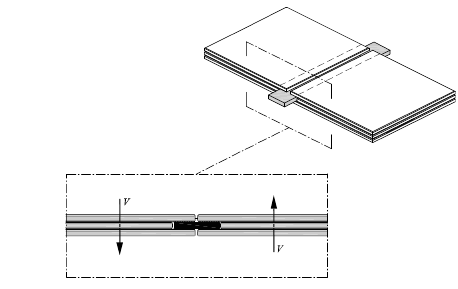
Figure 3: Configuration of stabilizing cables, developed by Vladimir Shukhov